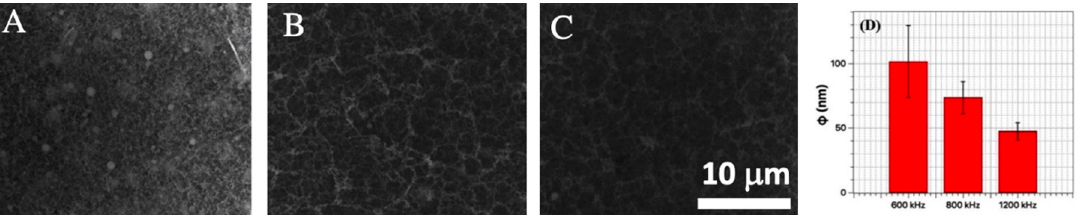
Figure 4. SEM images of ( A ) NFTi deposited layer on glass with laser frequency of 600 kHz; ( B ) NFTi deposited layer on glass with laser frequency of 800 kHz and ( C ) NFTi deposited layer on glass with laser frequency of 1200 kHz; ( D ) Column chart of fiber diameters by increasing laser frequency.